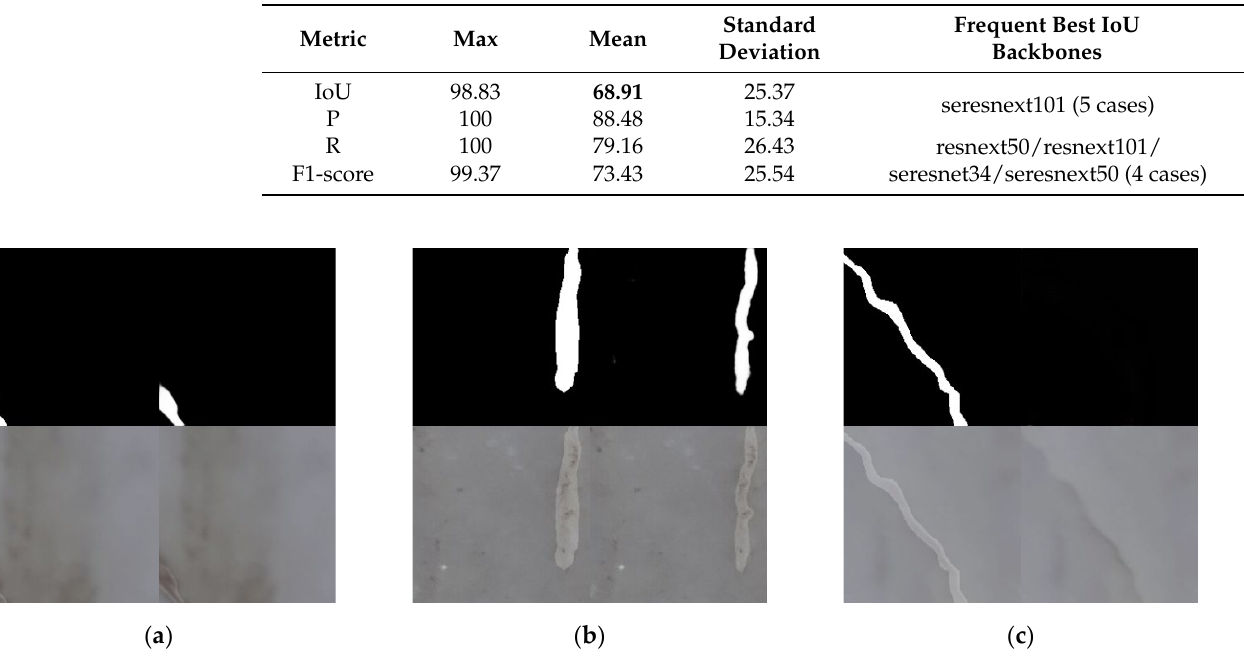
Figure 10. Indicative images of the testing set to illustrate U-Net performance. For each image: up–left is the ground truth image, down–left is the RGB input image, up–right is the output segmentation and down–right is the output segmentation mask applied to the input image. ( a ) Best (I ο U 98.83% with resnet50); ( b ) medium (I ο U 93.62% with efficientnetb1); ( c ) moderate (I ο U 29.91% with resnet101).